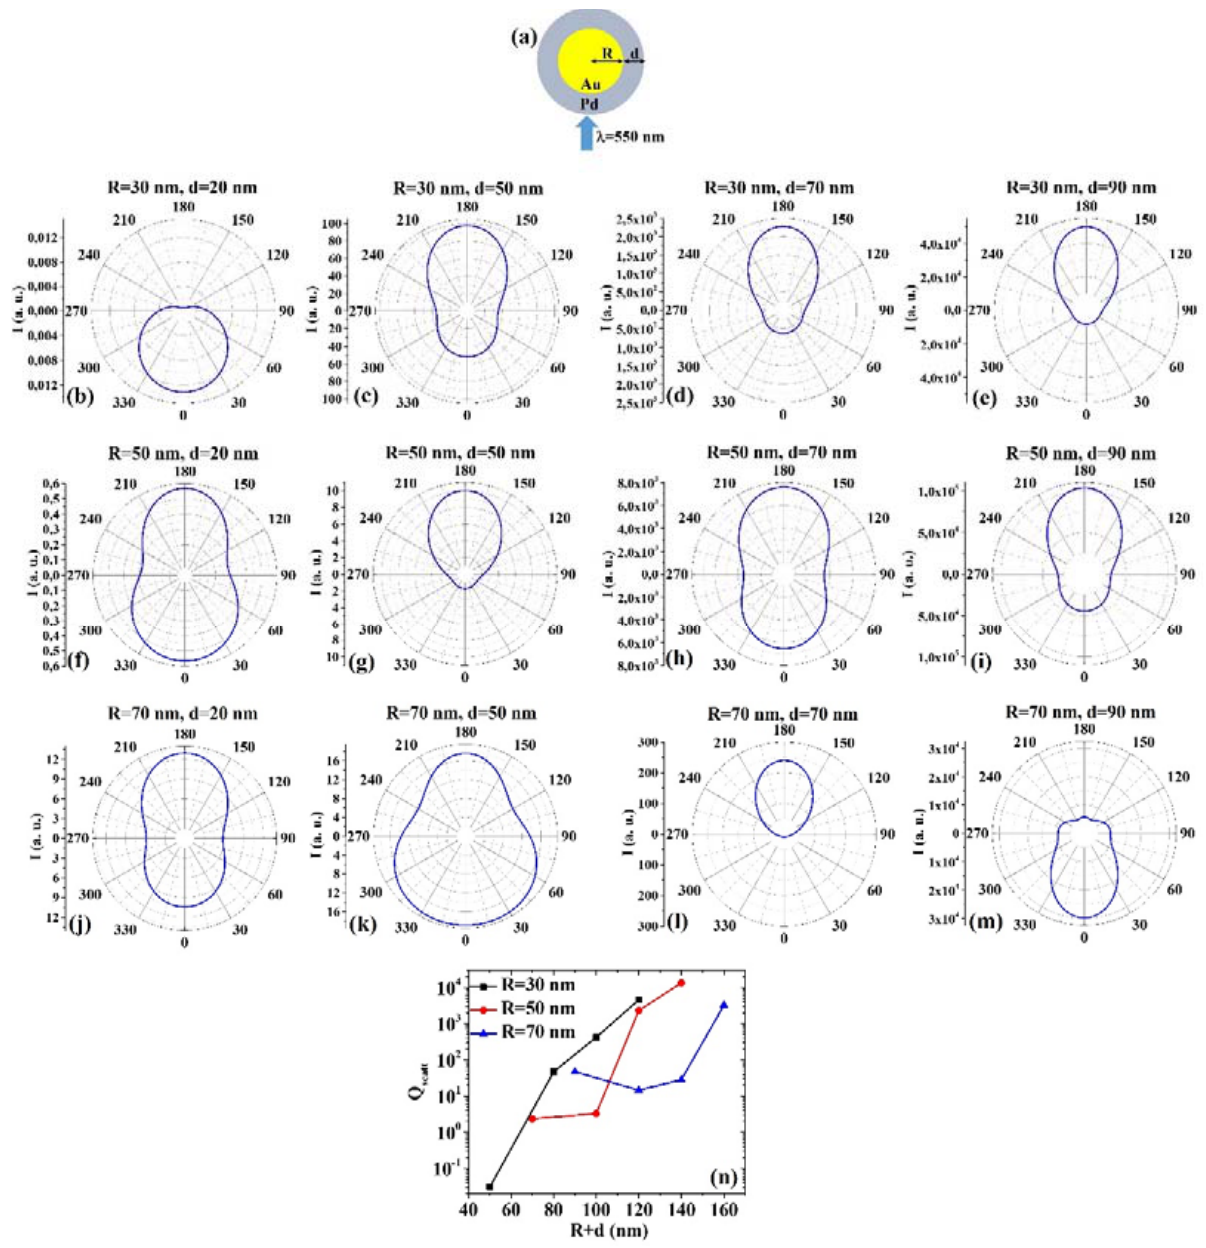
Figure 5. ( a ) Scheme of the structure of the simulated Au/Pd core/shell spherical particle with core radius R and shell width d and electromagnetic radiation of wavelength λ = 550 nm impinging on the particle from 0°. ( b – m ) Calculated polar diagrams for the intensity of the scattered light from the Au/Pd core/shell spherical particle changing the Au core radius R and the Pd shell width: ( b – e ) R = 30 nm and d = 20 nm ( b ), d = 50 nm ( c ), d = 70 nm ( d ), d = 90 nm ( e ); ( f – i ) R = 50 nm and d = 20 nm ( f ), d = 50 nm ( g ), d = 70 nm ( h ), d = 90 nm ( i ); ( j – m ) R = 70 nm and d = 20 nm ( j ), d = 50 nm (k), d = 70 nm ( l ), d = 90 nm ( m ). ( n ) Calculated scattering efficiency for the light (wavelength λ = 550 nm) scattering process of the Au/Pd spherical particle fixing the Au core diameter (R = 30 nm black dots, R = 50 nm red dots, R = 70 nm blue dots) and increasing the Pd shell width d from 20 nm to 90 nm.